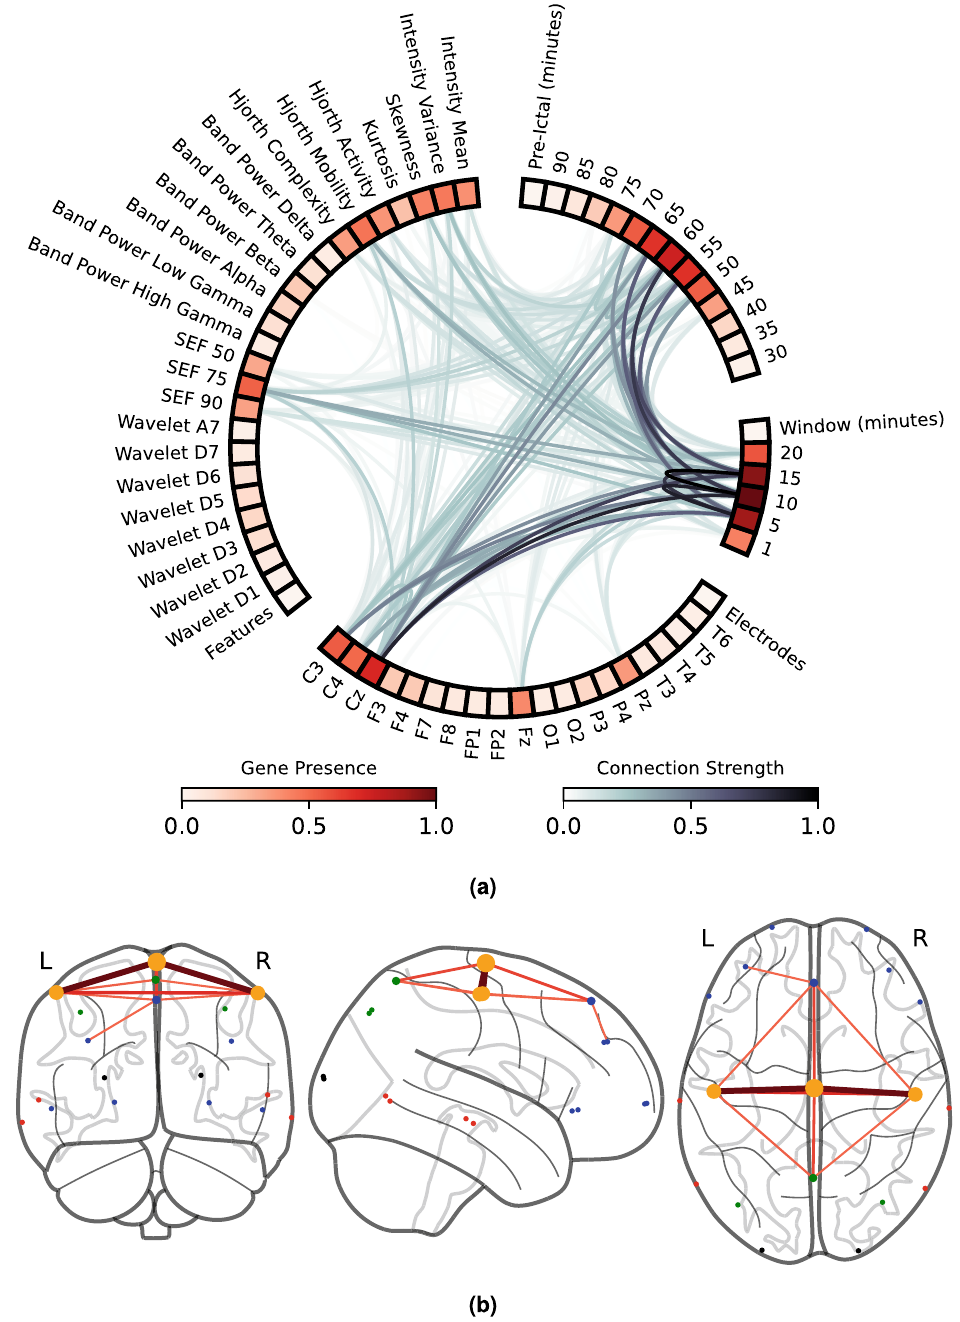
Figure 6. Gene interaction study for all patients. ( a ) Gene presence (red colourmap) and gene interaction (grey colourmap) in a chord diagram plotted using MNE Python library 61 . Gene presence is the ratio of times a given gene is present. Gene interaction is given by summing the association lift measures calculated with the a priori algorithm and then normalised to a 0–1 scale. ( b ) Brain connectivity was plotted using Nilearn Python library, and the 10–20 system electrodes were converted to the MNI coordinates 62 . Node size corresponds to the electrode presence, while edge colour and thickness provide connection strength (association lift). Node colour represents brain lobes (blue: frontal, orange: central, green: parietal, black: occipital, and red: temporal). A priori algorithm parameters: minimum support of 0.07, minimum confidence of 0.10, and minimum lift of